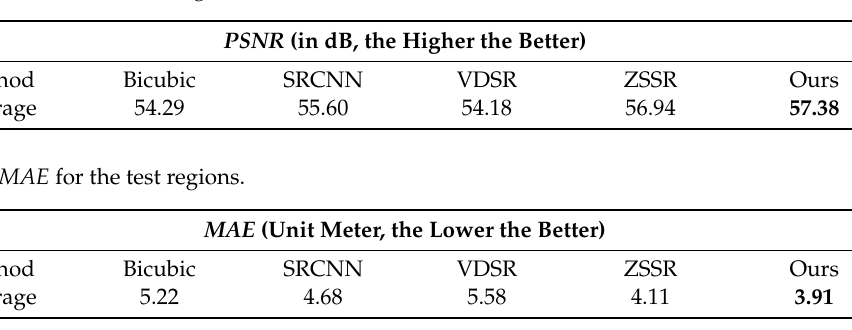
Table 6. PSNR for the test regions.